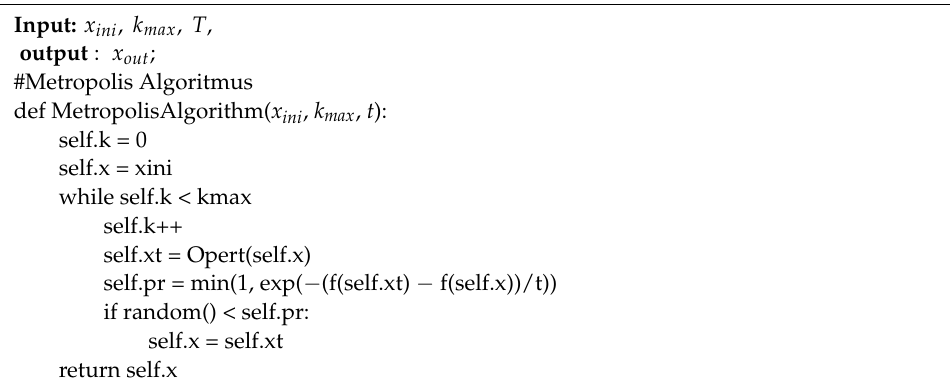
Algorithm 1. Procedure Metropolis algorithm.